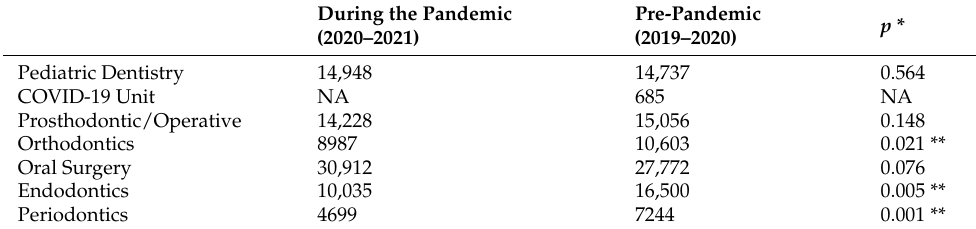
Table 3. Impact of the pandemic on attendance by specialty.